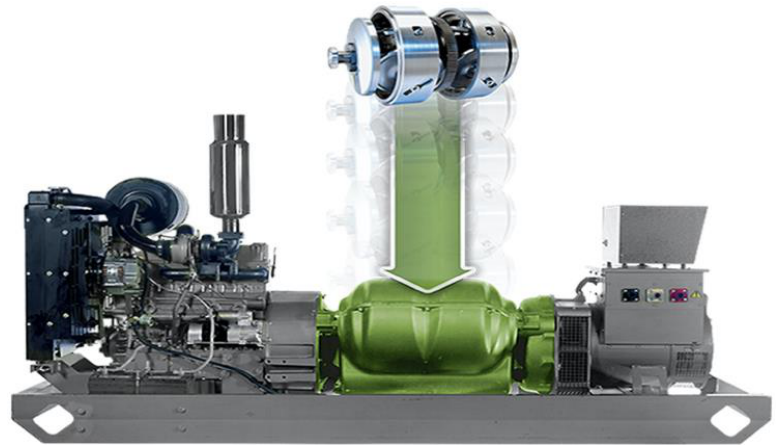
Figure 13. 125 KW powertrain using CVT technology [83].